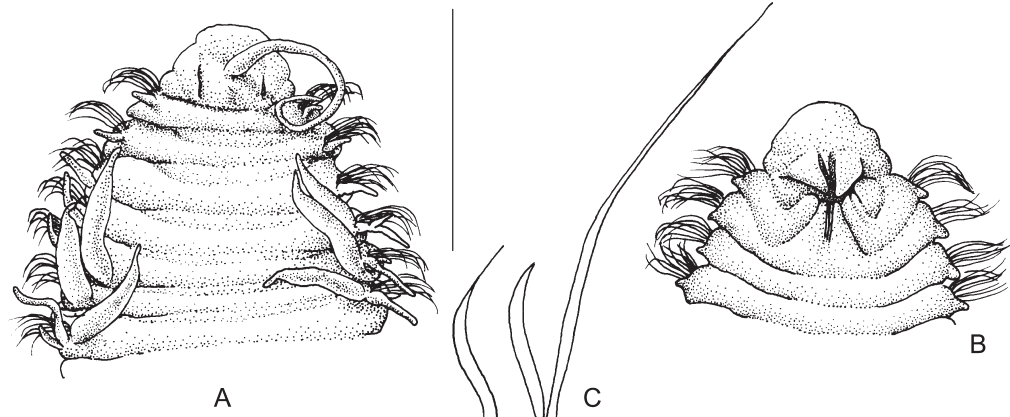
Fig . 14. – Aricidea ( Allia ) antennata : A, anterior region, dorsal view; b, anterior region, ventral view; c, modified ventral chaetae, chaetiger 39. Scale bar: A 820 µ m; b 850 µ m; c 60 µ